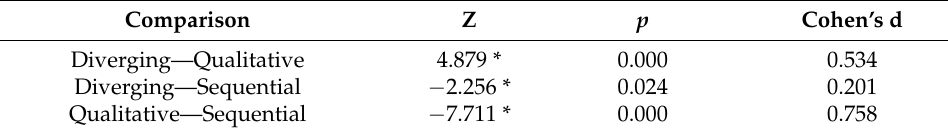
Table 7. The results of the post hoc test for color scheme group, with additional information—effect size (Cohen’s